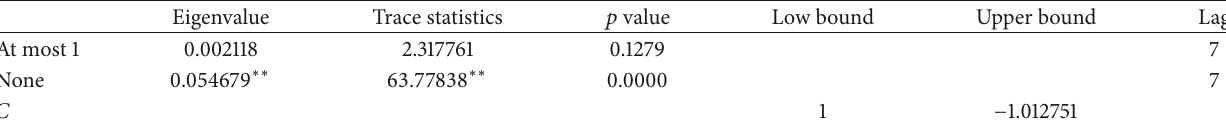
Table 5: Cointegration test